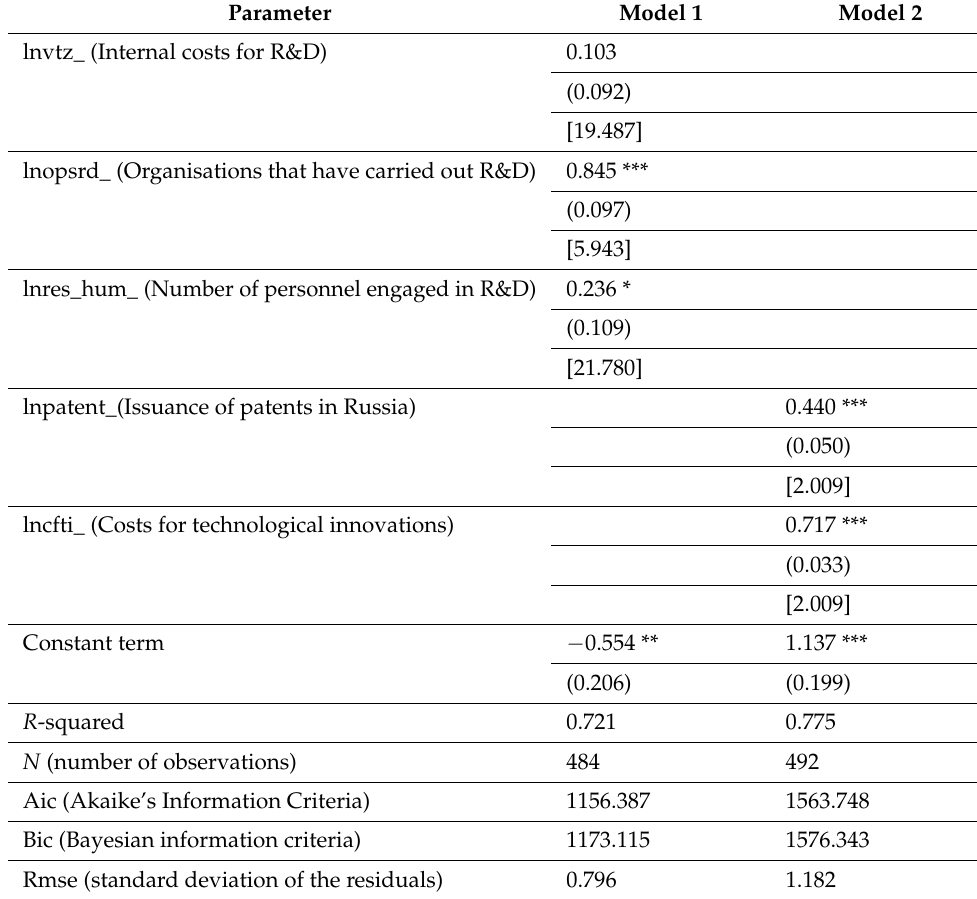
Table 4. Results of the regression analysis for model justification. Parameter Model 1 Model